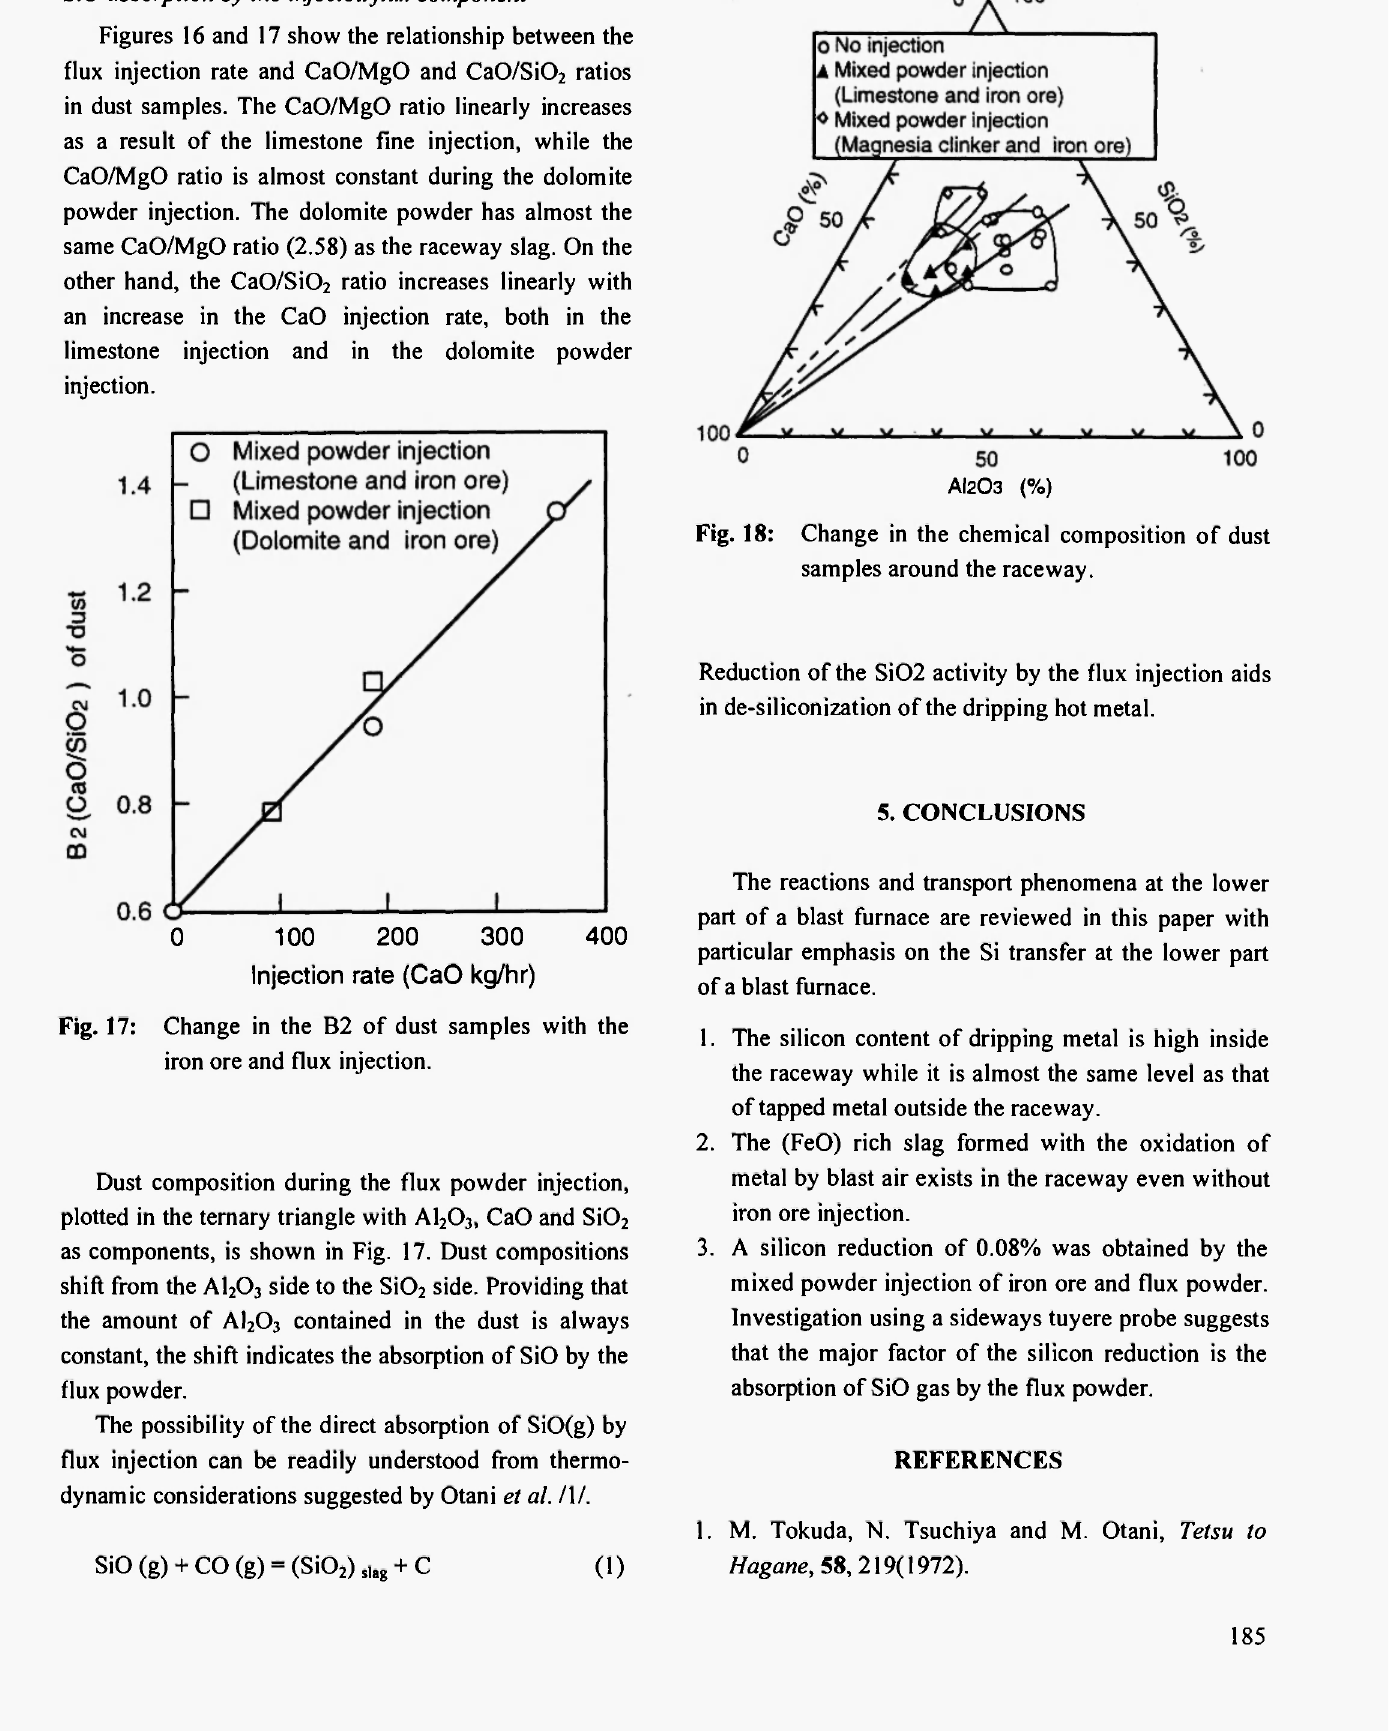
Fig. 18: Change in the chemical composition of dust samples around the